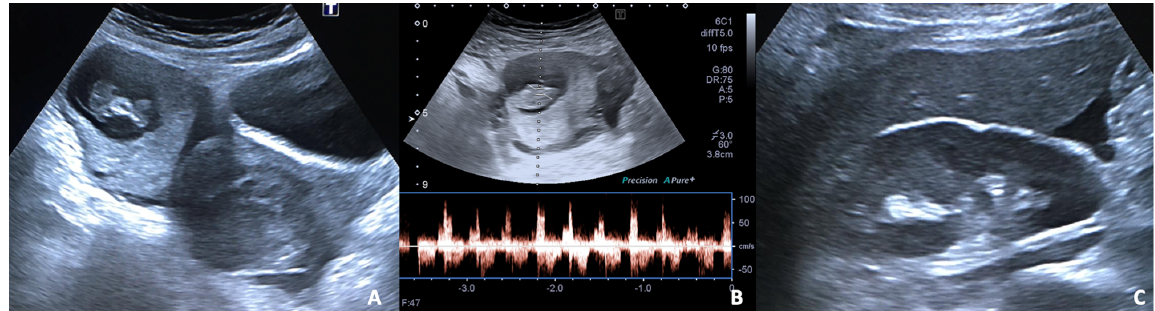
Figure 2. 27 y.o woman with vaginal bleeding and pelvic pain. ( A ) US examination shows an inhomogeneous mass (“blob sign”) morphologically similar to a gestational sac in the right ovary; ( B ) cardiac activity is detected on power doppler; ( C ) free fluid is also present at the hepato-renal